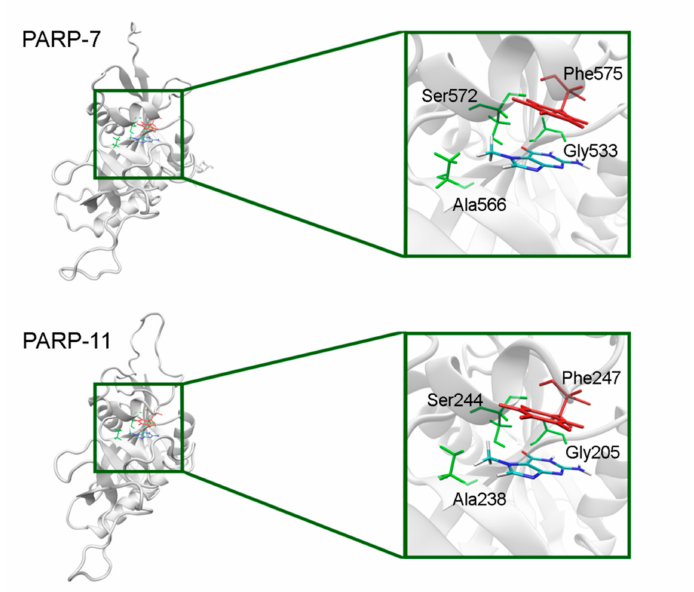
Figure 12. 7-MG position in the NA binding site of PARP-7 and 11 obtained using homology modeling. The conserved NA site residues are colored in green and unique residues in red.